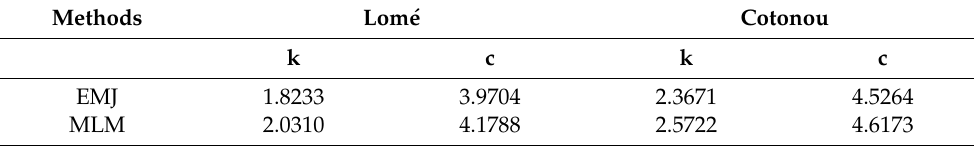
Table 4. Weibull parameters obtained with EMJ and MLM for the sites of Cotonou and Lom é . Methods